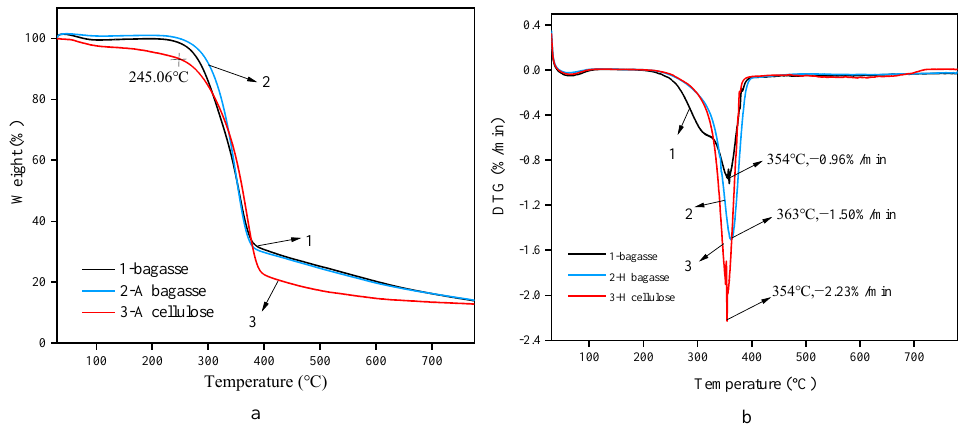
Figure 8. Thermogravimetric curves TG ( a ) and DTG ( b ) of two stages of hydrothermal extraction. (Among them, 1-bagasse; 2-bagasse HB after hydrothermal extraction; 3-cellulose HC after hydrothermal